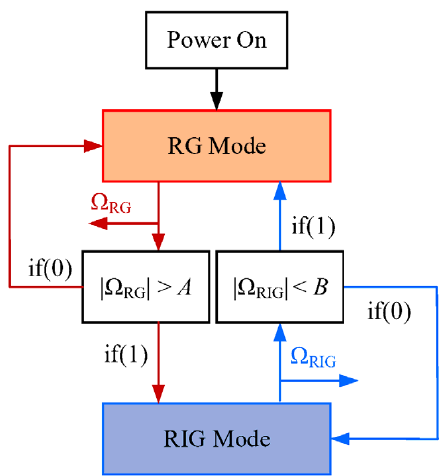
Figure 4. Concept of switching between RG and RIG modes.